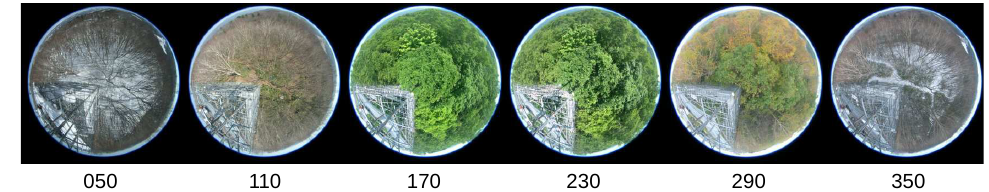
Figure 4. Examples of fisheye images taken by ADFC. These images were taken in 2019 at TKY. The bottom numbers represent day of year (DOY). Table 3. Data acquisition intervals of MS-700 and Automatic-capturing Digital Fisheye Camera (ADFC) in the study sites. The time is described according to Japan Standard Time